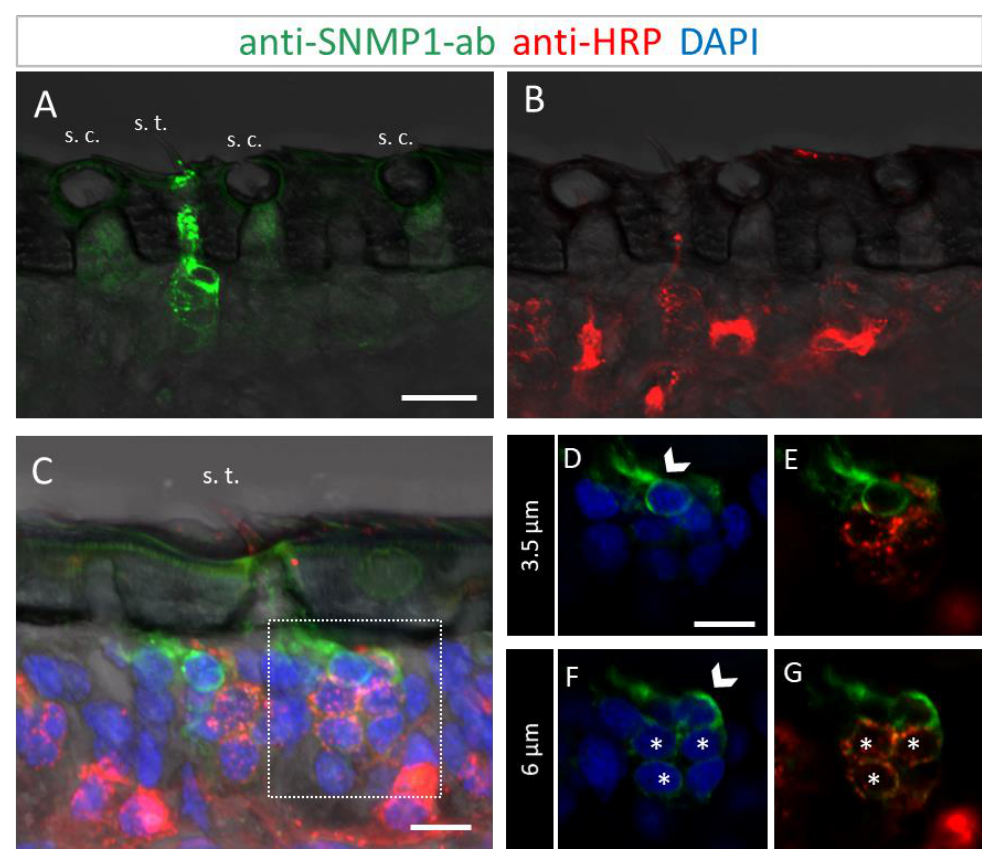
Figure 3. SNMP1 is localized in OSNs of trichoid sensilla (s. t.) but not of coeloconic sensilla (s. c.) in S. gregaria . In FIHC experiments with antennal sections, SNMP1-expressing cells (green) were visualized by anti-SNMP1-ab and neurons (red) by the anti-HRP-antibody. DAPI was used to stain nuclei (blue). ( A , B ) show anti-SNMP1-ab labelling of cells in trichoid, but not of coeloconic sensilla ( A ) and OSNs innervating the two sensilla types visualized in the red fluorescent channel ( B ). ( C , A ) trichoid sensillum from another treated section. ( D – G ) show a higher magnification of the area boxed in C showing the cell at the base in different optical planes and channels. ( D , E ) A non-neuronal, SNMP1-positive support cell is visible above an OSN cluster on a higher optical plane. ( F , G ) A second non-neuronal SNMP1-positive support cell as well as three OSNs are visualized in a deeper optical plane. Arrows indicate the SNMP1-positive support cells, asterisks the SNMP1-positive OSNs. The transmitted light channel was overlaid with the fluorescent channels in ( A – C ). Scale bars: ( A ) = 20 μm, ( C , D ) = 10 µm.